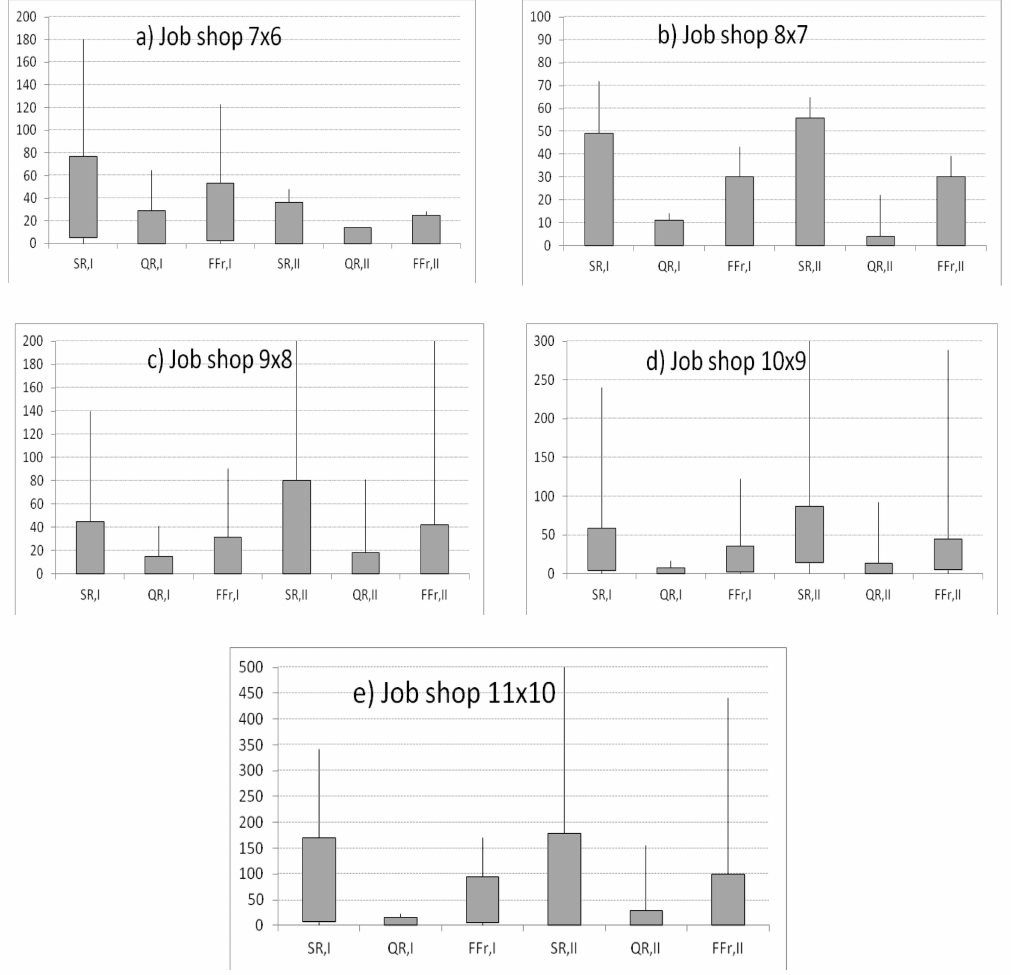
Figure 5. Reactive schedules assessed using solution robustness ( SR ), quality robustness ( QR ), and weighted function of SR and QR ( FF r) for reliability input data anticipated using the maximum likelihood approach (dataset I) and empirical moments method (dataset